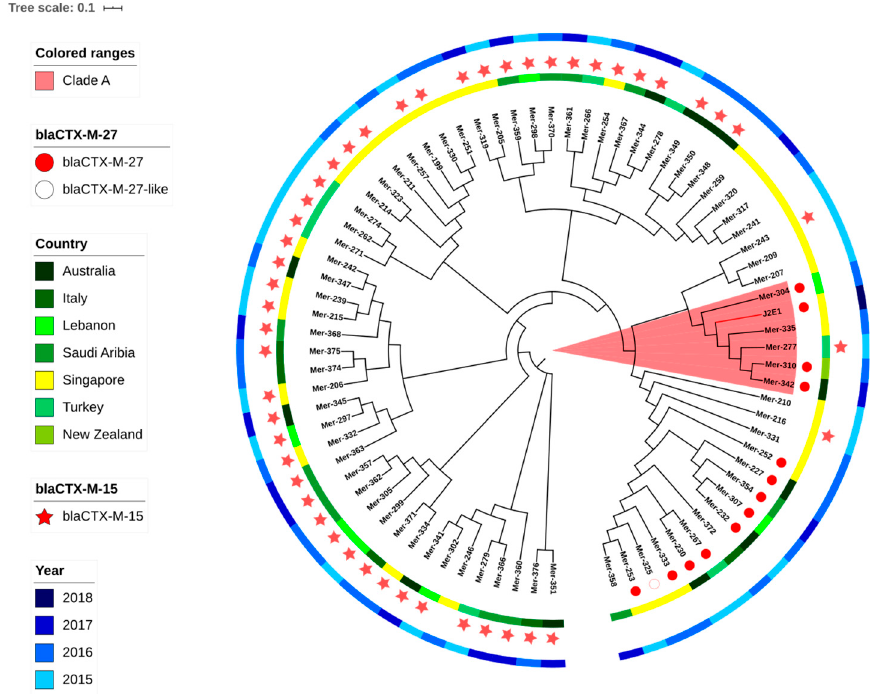
Figure 1. The phylogenetic tree of ST131 isolates from both the clinic and reservoir based on core genome single ‐ nucleotide polymorphisms (SNPs). The tree was built with E. coli MG1655 as the reference genome and branch length was ignored. J2E1 was isolated in this research and or the other isolates were from NCBI. The metadata is shown in the supplementary.